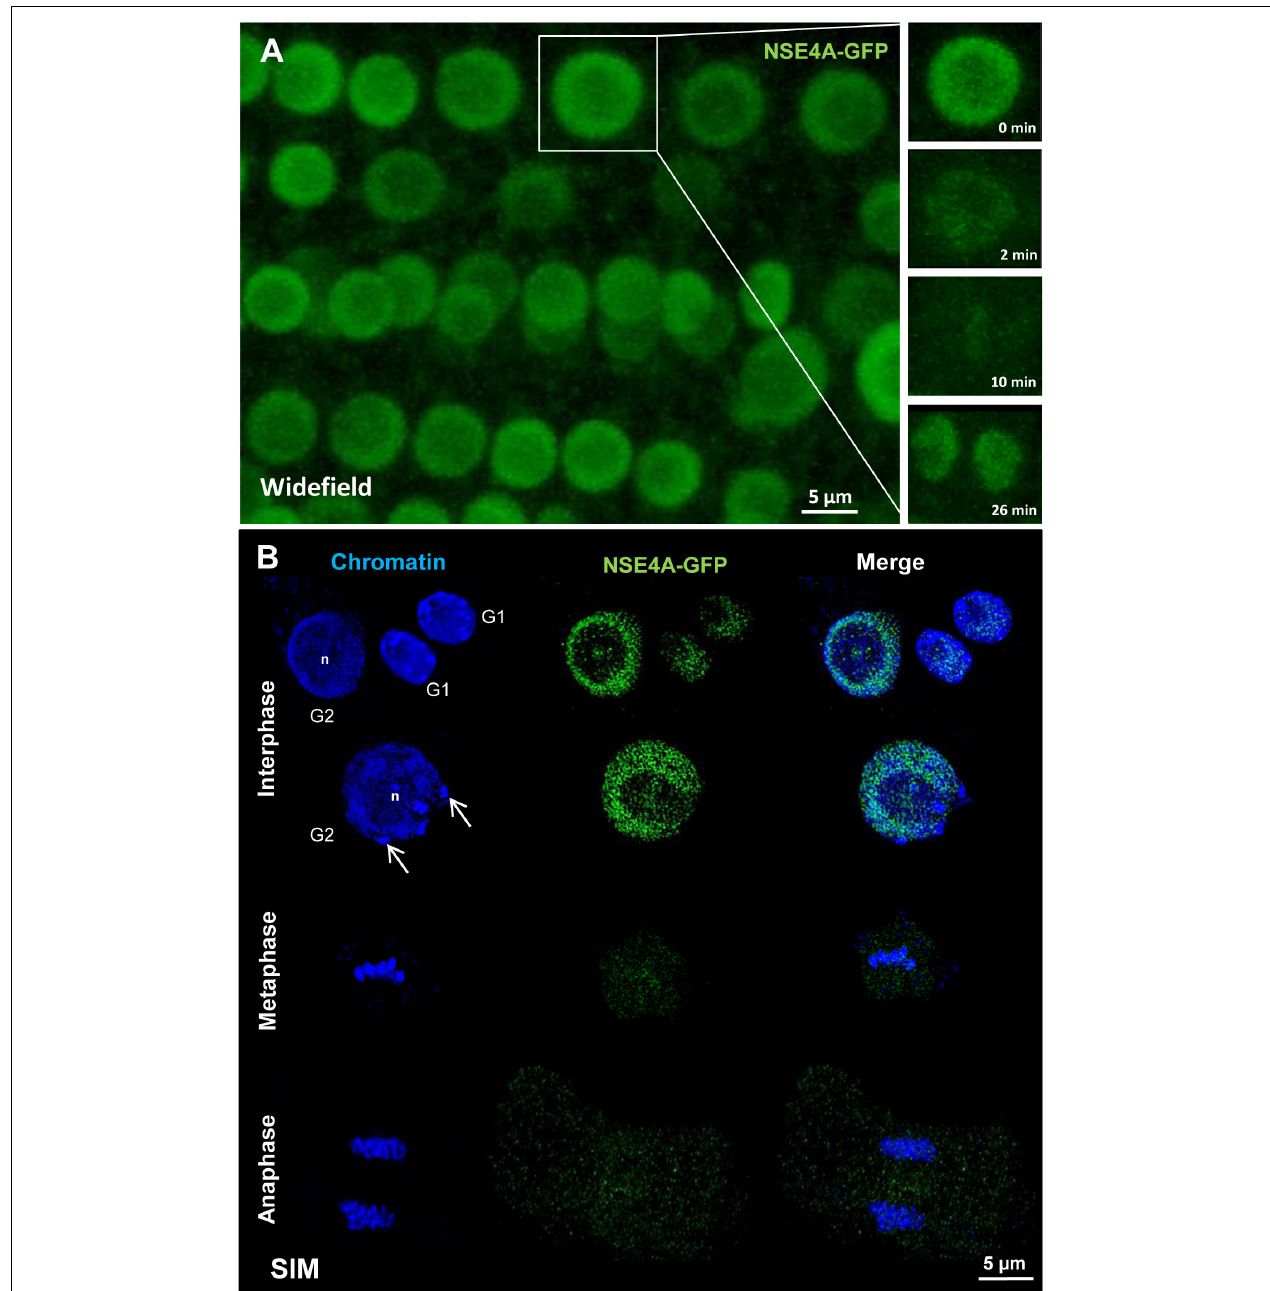
FIGURE 6 | The localization of NSE4A in root meristem cells. (A) Global view of a living A. thaliana root meristem expressing a genomic NseA ::GFP construct under the control of the endogenous Nse4A promoter. The cell undergoing mitosis (in the rectangle) shows that the nuclear NSE4A-GFP signals are present in interphase (0 min), disappear from the chromosomes during metaphase (2–10 min) and are recovered in telophase at chromatin (26 min). During metaphase a slight cytoplasm labeling is visible. (B) The ultrastructural analysis by super-resolution microscopy (SIM) confirms the presence of NSE4A within euchromatin, and indicates its absence from the nucleolus (n) and heterochromatin (chromocenters, arrows) in root meristem G1 and G2 nuclei. During meta- and anaphase NSE4A mainly disappears from the chromosomes, but stays slightly present within the cytoplasm. In young daughter nuclei (G1 phase) NSA4A becomes recovered. The localization of NSE4A-GFP expressed by pnse4A::gNse4A::GFP transgenic A. thaliana plants was detected by anti-GFP antibodies in fixed